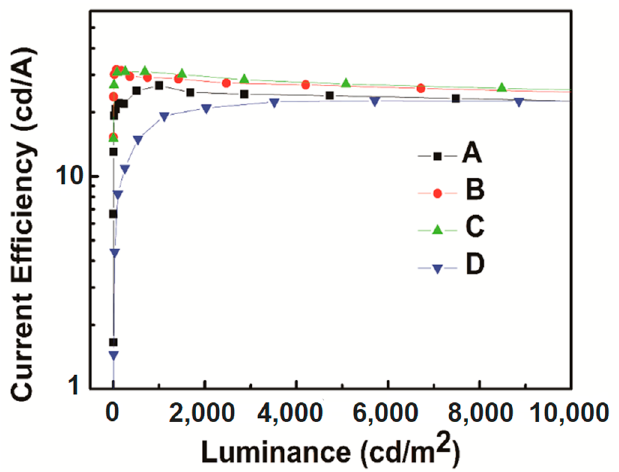
Figure 2. The current efficiency-luminance characteristics of devices A–D.